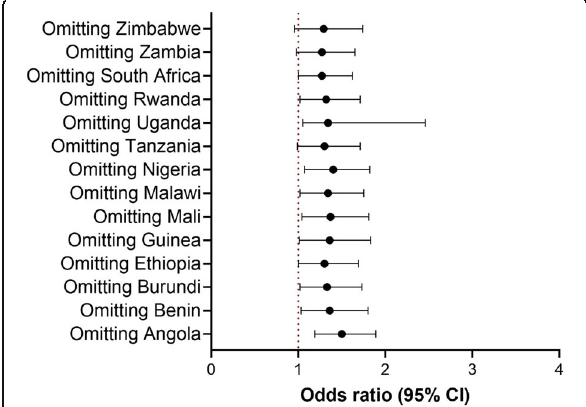
Fig. 4 Association between HAP exposure and under-5 mortality: leave-one-out analysis for model